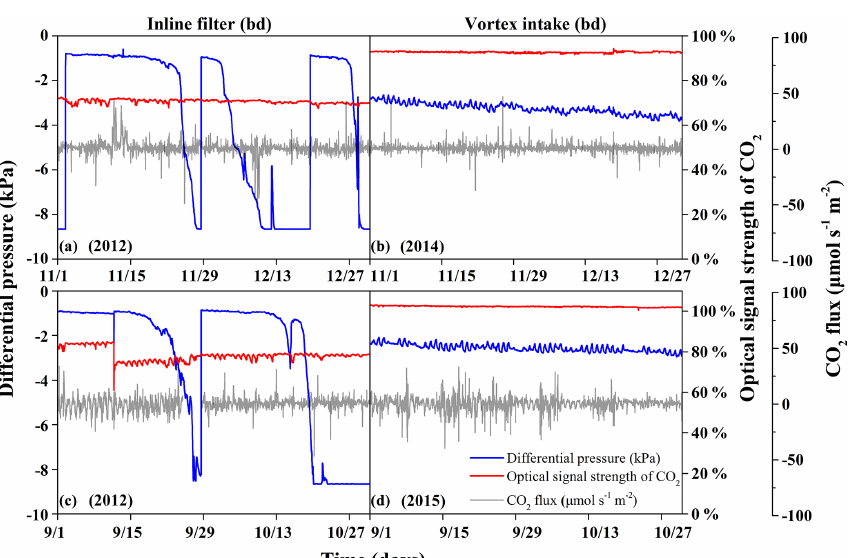
Figure 6. Differential pressure (blue line), optical signal strength of CO 2 (red line) and CO 2 flux (gray line) of the EC system (EC155) equipped with vortex intake as compared to an inline filter at the Badaling Farm (bd); panels (a) and (b) are for periods of very hazy conditions, whereas panels (c) and (d) are for periods of low